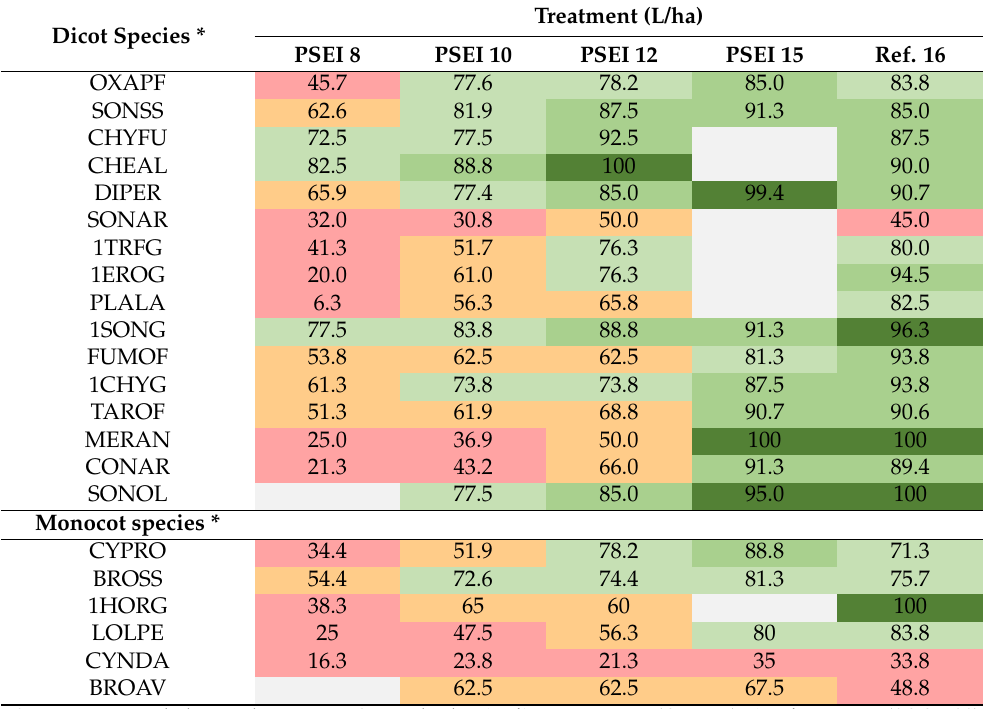
Table 9. Herbicide efficacy per species (dicotyledonous and monocotyledonous identified weeds). Dicot Species